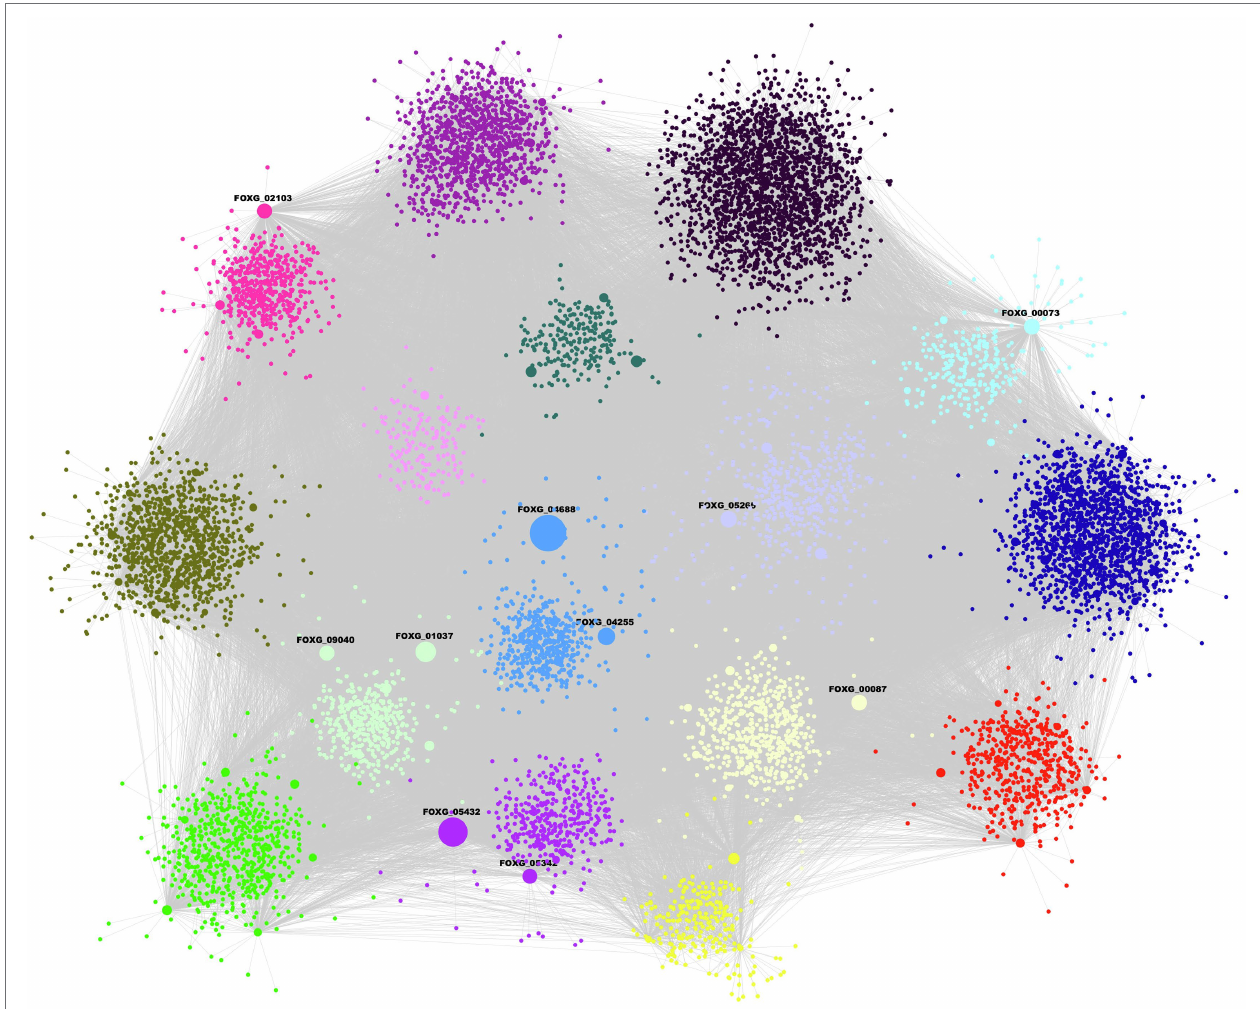
FIGURE 1 | Gene regulatory network (GRN) of Fusarium oxysporum . Each color represents a different community and the size of the node is proportional to the output degree. Ten TFs are plotted as highly connected nodes, and these regulate 50.28% of the network